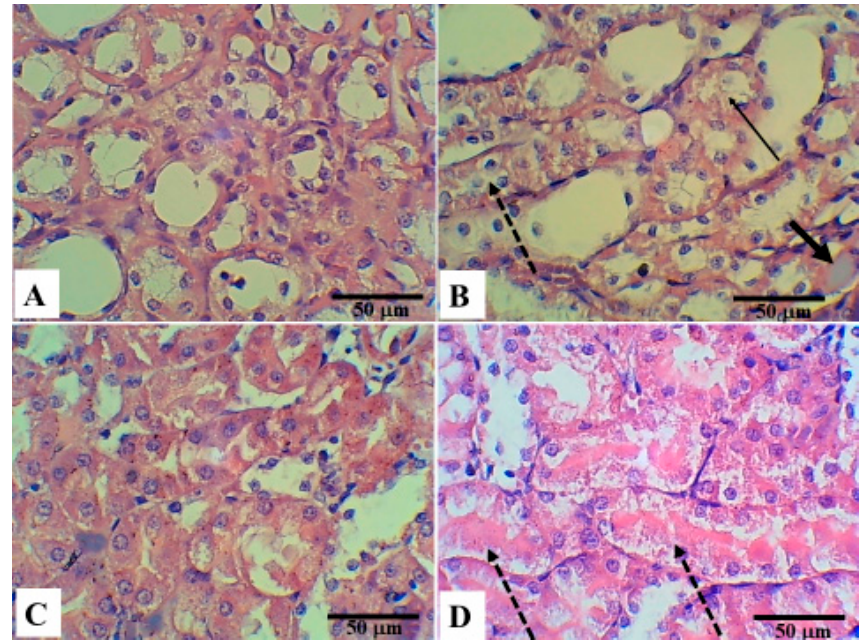
Figure 2. Tubular changes in in the four groups. When compared with the control group, GM induced vacuolar degeneration (thin arrow) and tubular irregularities (dotted arrow). The hyaline droplets seen in the GM-treated group (thick arrow) were reduced in the TQ-treated and MF-treated groups, and the tubular regularity preservation was more pronounced in the TQ-treated group. ( A ): Control group; ( B ): GM-treated group; ( C ): TQ-treated group; ( D ): MF-treated group. H&E staining.